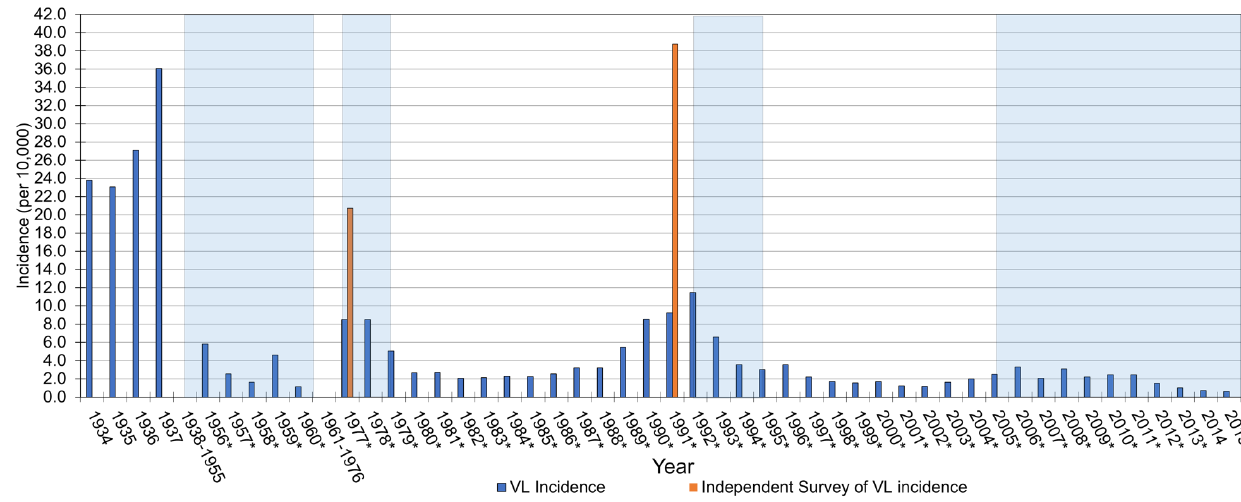
Figure 1. Historical Overview: Annual VL Incidence in Bihar and IRS activities. The dark blue bars represent the annual VL incidence per 10,000, as reported by the VL Programme (GOB only). In the absence of historical population at risk data, the total population in Bihar was used to calculate incidence. Independent surveys conducted in 1977 by National Institute of Communicable Diseases, Delhi and GOB and 1991 by Government of India under the Malaria Department, reported VL incidence per 10,000 is shown in orange for those two years (GOB&I). Light blue shading represents years where IRS was ongoing, whilst white represents years where IRS was stopped. Years marked with an asterisk were used in analysis of climatic, case and IRS